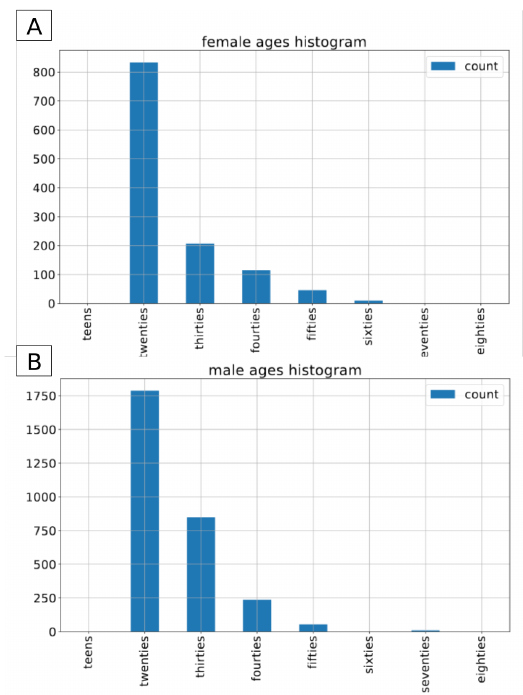
Figure 4. TIMIT: age distribution by gender in the train dataset. ( A ) female speakers, ( B ) male speakers.